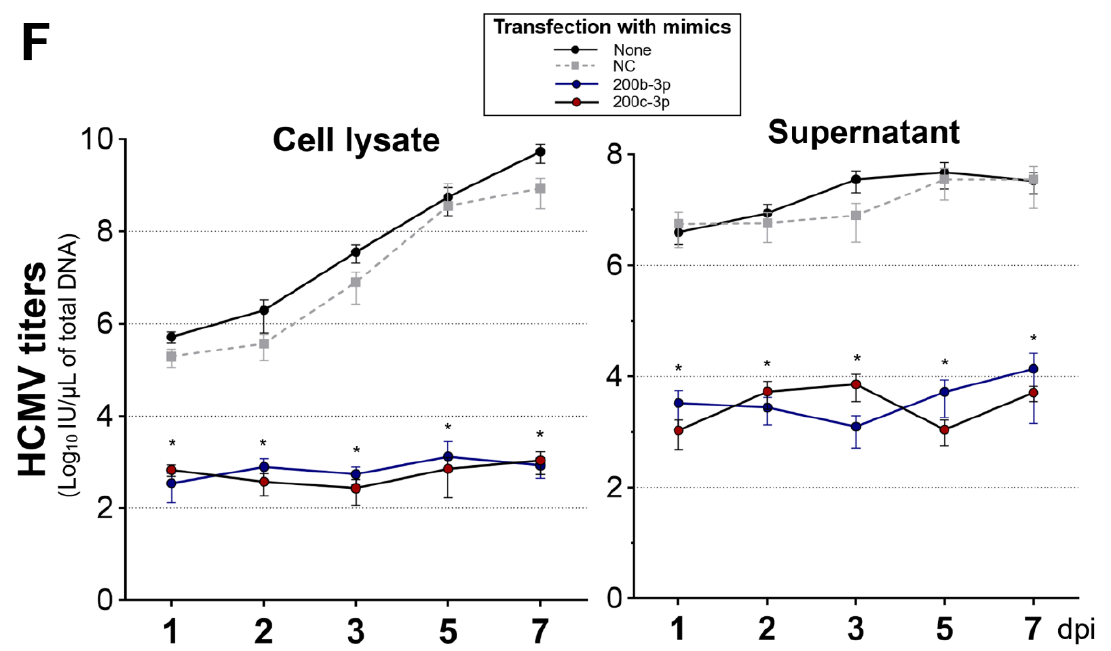
Figure 3. Downregulated expression of miR-200b-3p and miR-200c-3p in the background of acute HCMV infection was associated with IE72 and IE86 expression and HCMV replication. ( A ) Copies of endogenous miR-200b-3p and miR-200c-3p at 1, 2, 3, 5, and 7 days during HFF-1 cell culture with or without HCMV Towne strain (0.1 of MOI) measured using quantitative real-time reverse- transcription PCR (RT-PCR) with small RNAs isolated from pelleted cells (1 × 10 6 /well; 6-well plates). Absolute levels of miRNAs in independent standard curves for separate experiments are expressed as copies/ µ L of total RNA determined using real-time RT-PCR. Data are representative of triplicate measurements in three separate experiments for each miRNA per day. Expression of miR-200b-3p and miR-200c-3p in cells with and without HCMV infection ( B , left panel ) was estimated on days 1, 2, 3, 5, and 7 (total 45 measurements); then, correlations between them were determined ( B , right panel ). Middle and error bars indicate means and standard deviation, respectively, in the left panel. ( C ) HFF-1 cells (1 × 10 6 /well) were infected at 2 dpi with HCMV Towne strain at an MOI of 0.1 in 6-well plates and then transfected with miR-200b-3p, miR-200c-3p, or NC mimic (300 ng each). ( D ) The band intensity of IE72 and IE86 in immunoblots is expressed as fold value of cells that were not transfected with mimic (triplicate independent results from miRNA mimic-transfected HFF-1 cells). ( E ) Antisense inhibitor was transfected into HFF-1 cells 1 h after the simultaneous exposure to HCMV and mimic. Thereafter, the expression of IE72 and IE86 was investigated at 2 dpi. ( F ) Absolute HCMV titers in HFF-1 cells transfected with miR-200b-3p, miR-200c-3p, or NC mimic measured at 1, 2, 3, 5, and 7 dpi by measuring the expression of UL83 using real-time PCR (left panel, cell lysates; right panel culture supernatants). HCMV viral load determined as log 10 IU/ µ L in total DNA by PCR. Plot depicting HCMV titers represents triplicate measurements in three separate experiments per day. Upper lines in box or dot and error bars in ( A , B , D , F ) indicate means and SEM, respectively. * p < 0.001, compared with cells without HCMV infection ( A ) or transfected with NC mimic ( D , F